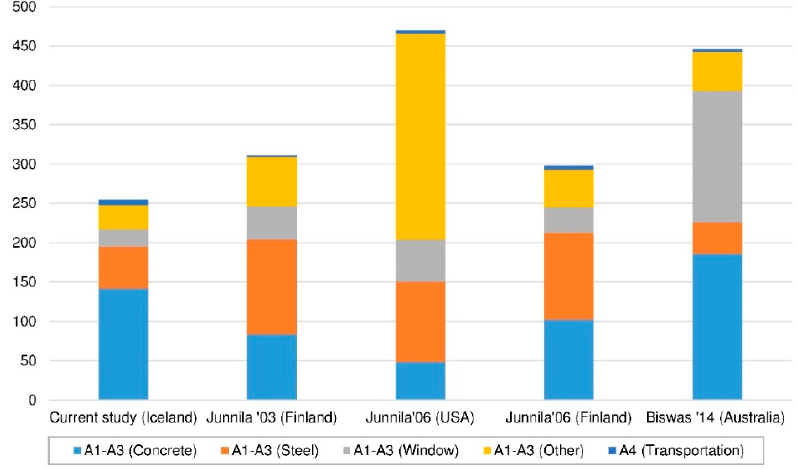
Figure 5. Compares the GWP impact of the Vættaskóli-Engi school building per square meter of gross floor area with similar LCA studies. The impacts are grouped based on construction materials and modules as defined in EN 15804.